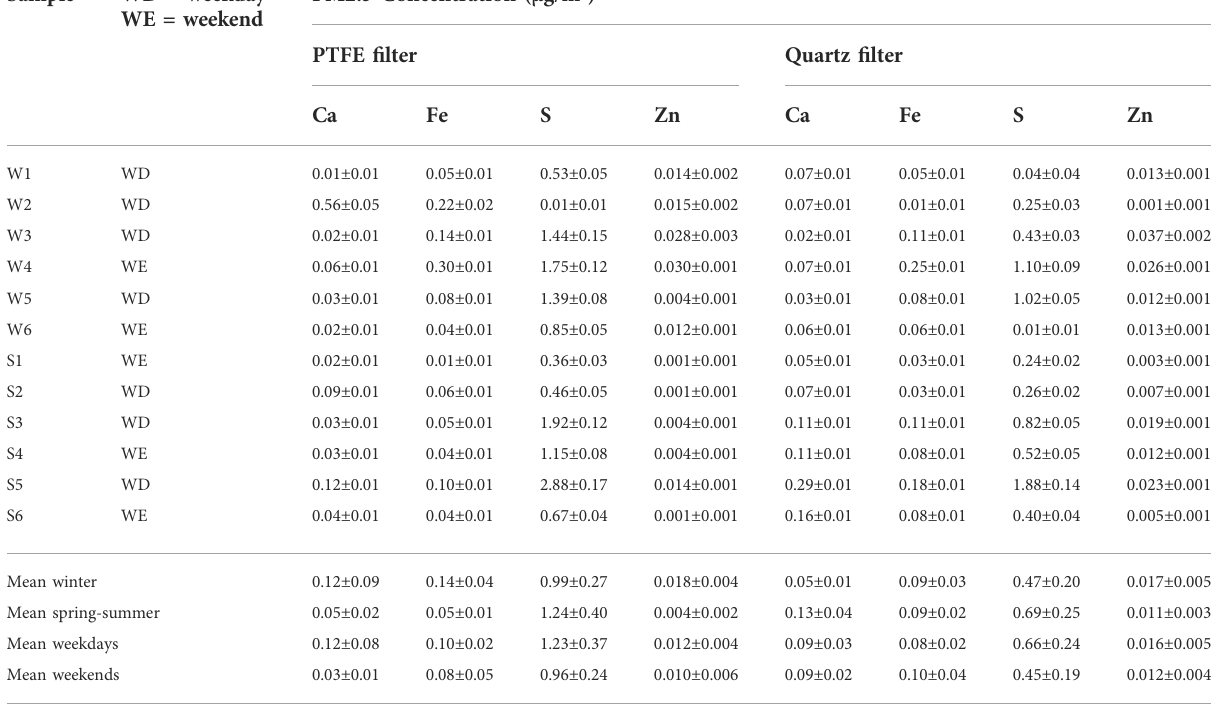
TABLE 2 Calcium (Ca), iron (Fe), sulphur (S), and zinc (Zn) concentrations (± corresponding uncertainties) determined by PIXE using PTFE and quartz fi lters for each analyzed PM2.5 sample. The weekday/weekend indication has been also reported for each analyzed sample. The corresponding mean values (± standard error of the mean) for winter, spring-summer, weekday, and weekend samples have been also